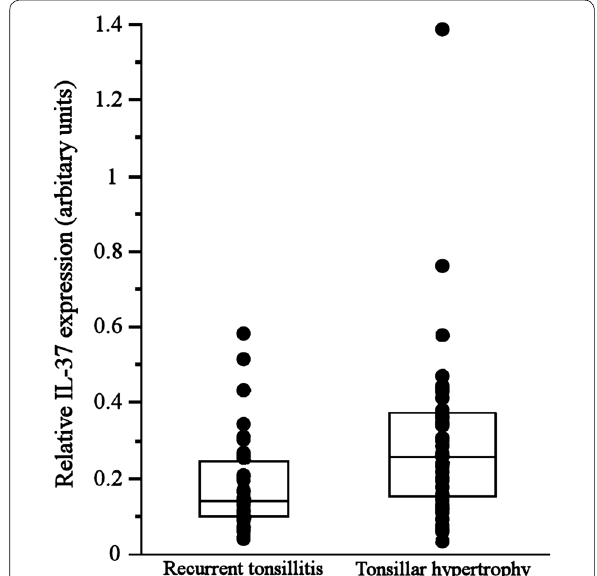
Fig. 2 Relative tonsillar expression of IL-37. Forty-two recurrent tonsillitis samples compared with 47 hypertrophic tonsil samples. Values are arbitrary units x 10 4 relative to EF1α. Data are represented as median with interquartile range. IL-37, Interleukin